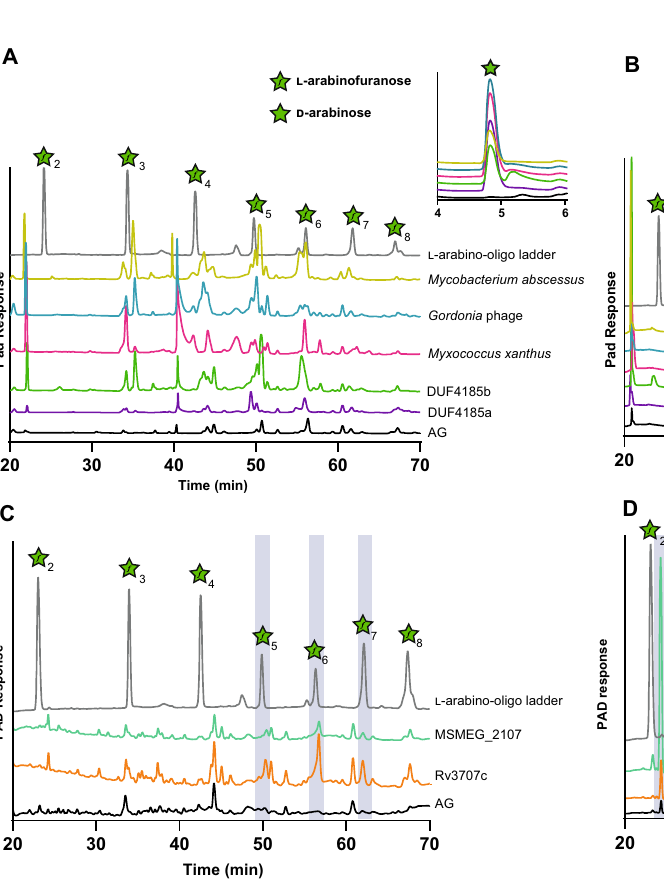
Fig. 4 | DUF4185 proteins are endo- D -arabinofuranases that cleave myco- bacterial AG and LAM. DUF4185 enzymes were incubated with 2mg ∙ ml − 1 AG ( A and C ) or 2mg · ml − 1 LAM ( B and D ) for 16hours as described in Materials and Methods. Samples were analyzed by ion chromatography with pulsed ampero- metric detection (IC-PAD) on a Dionex ICS-6000w with CarboPac Pa300 column,